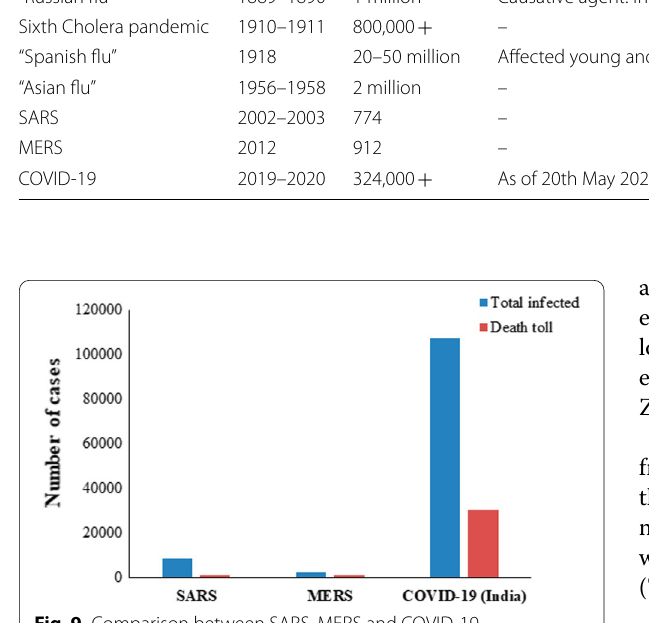
Fig. 9 Comparison between SARS, MERS and COVID-19